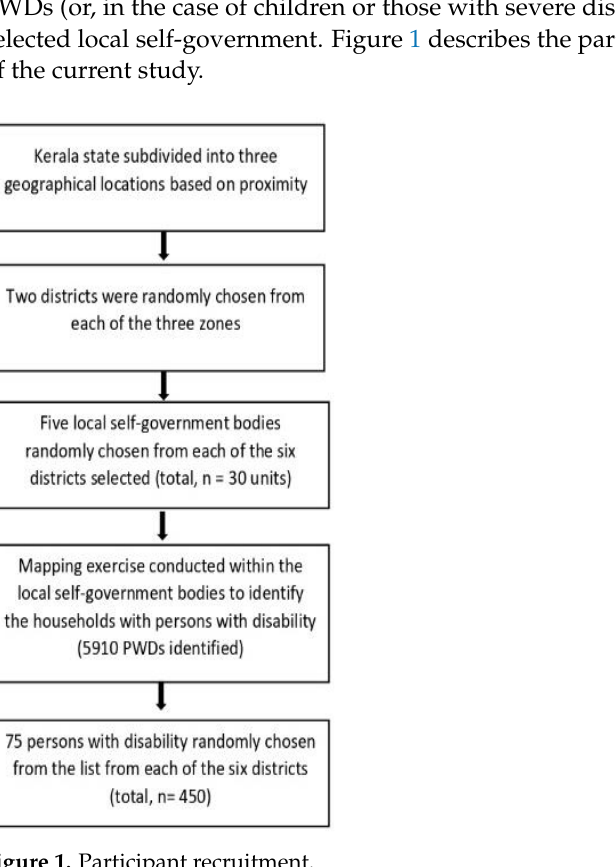
Figure 1. Participant recruitment.